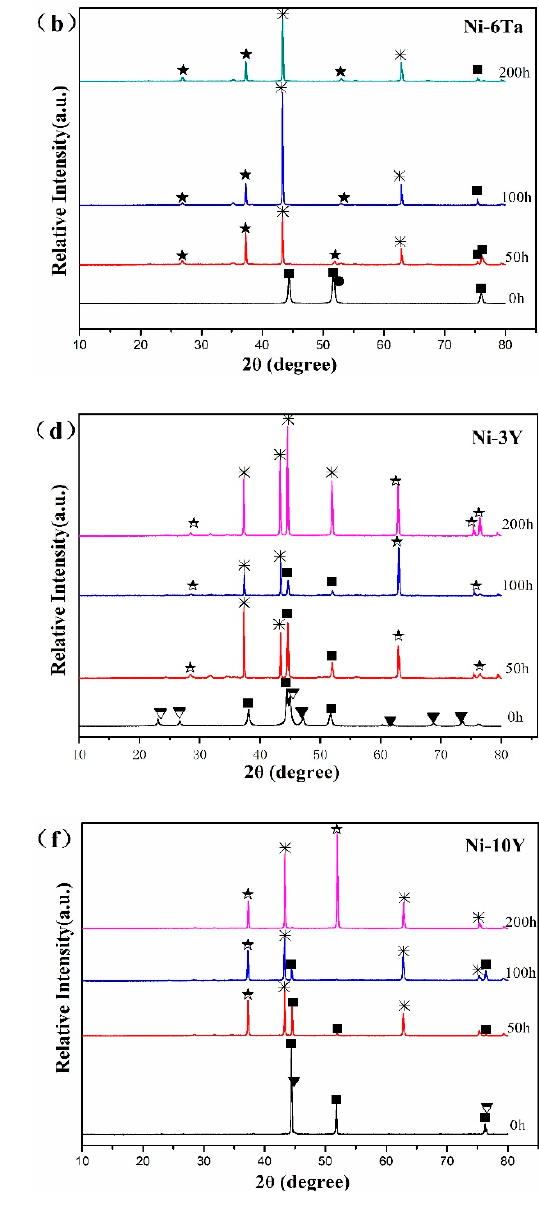
Figure 5. XRD patterns of Ni ‐ (3~10) Ta and Ni ‐ (3~10) Y alloys at 800 °C for up to 200 h: ( a–c ) Ni ‐ (3~10) alloys, ( d–f ) Ni ‐ (3~10) alloys. Phases: ( ■ ) Ni; ( ● ) Ni 2 Ta; ( ▼ ) Ni 4 Y; ( ) Ni 3 Y; ( ★ ) Ta 2 O 5 ; ( ) Y 2 O 3 ; ( ) NiO.